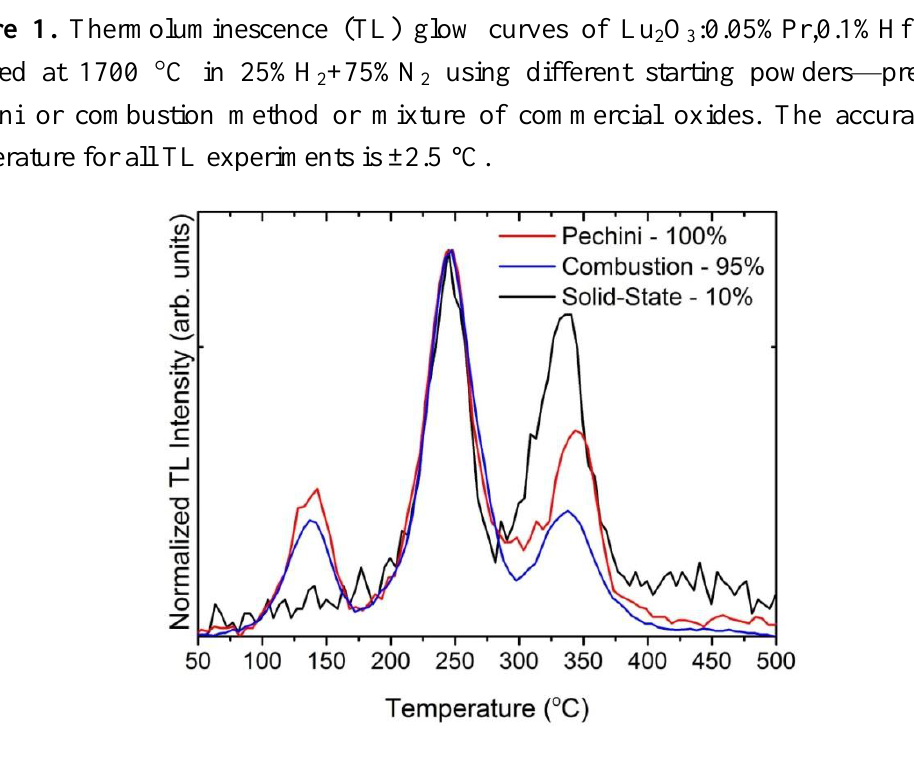
O :0.05%Pr,0.1%Hf ceramics 2 3 +75%N using different starting powders—prepared by 2 2